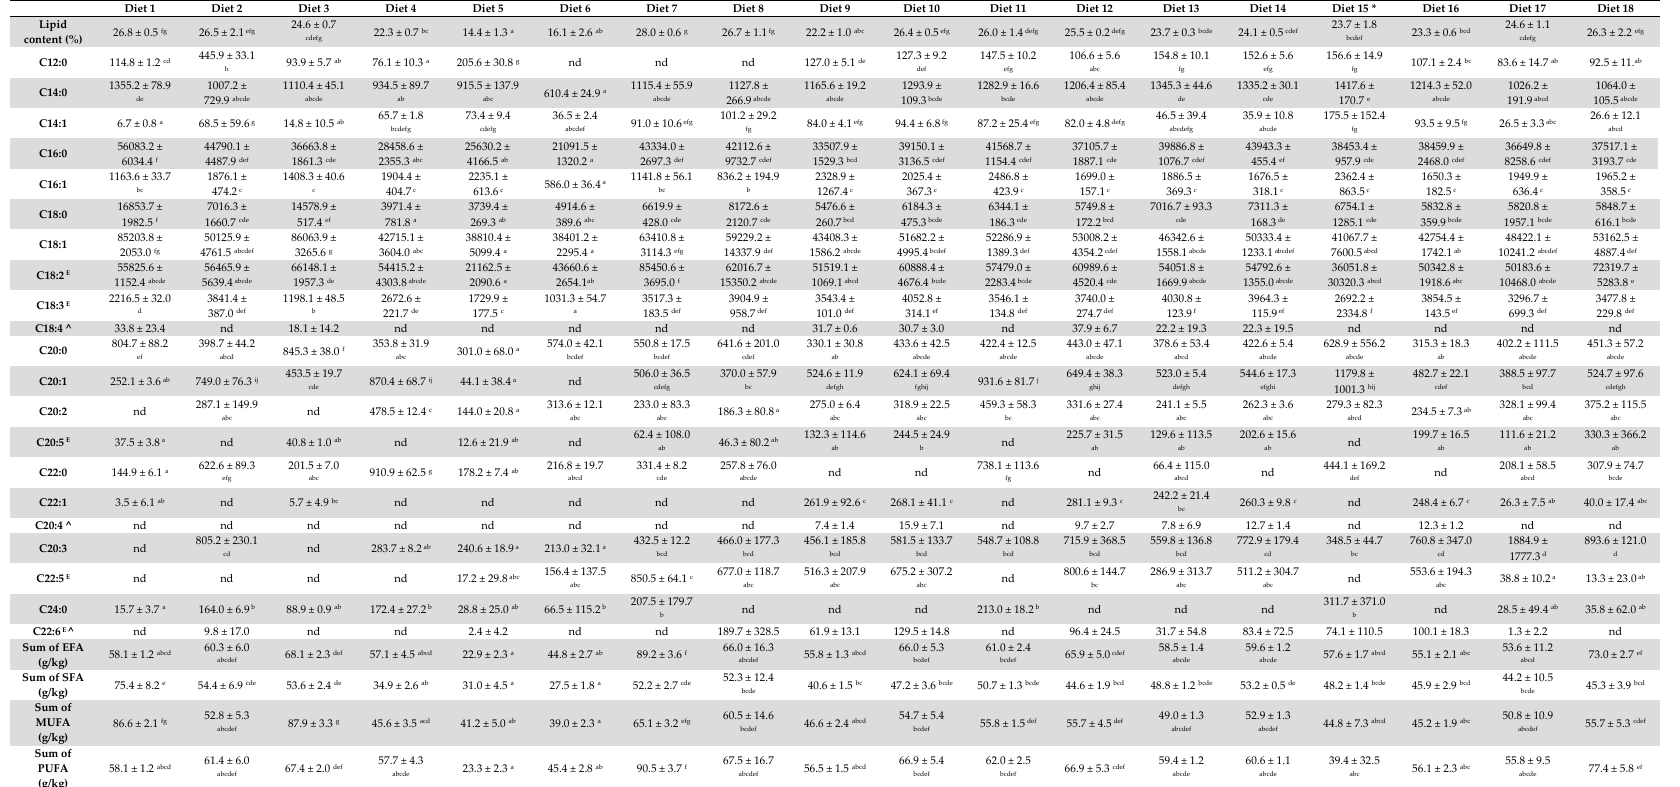
Table A5. Lipid content (%), fatty acid composition (mg / kg) and sum of essential fatty acids (g / kg) of the larvae on dry matter basis (mean ± SD), E ssential fatty acids, * analysis performed in duplicate, SFE: saturated fatty acids, MUFA: monounsaturated fatty acid, PUFA: polyunsaturated fatty acids, nd: not detected, letters in superscript represent the Kruskal–Wallis analysis post-hoc analysis performed on the each parameters (ˆ indicates if no significant di ff erences were observed). Insects 2019 , 10 , x FOR PEER